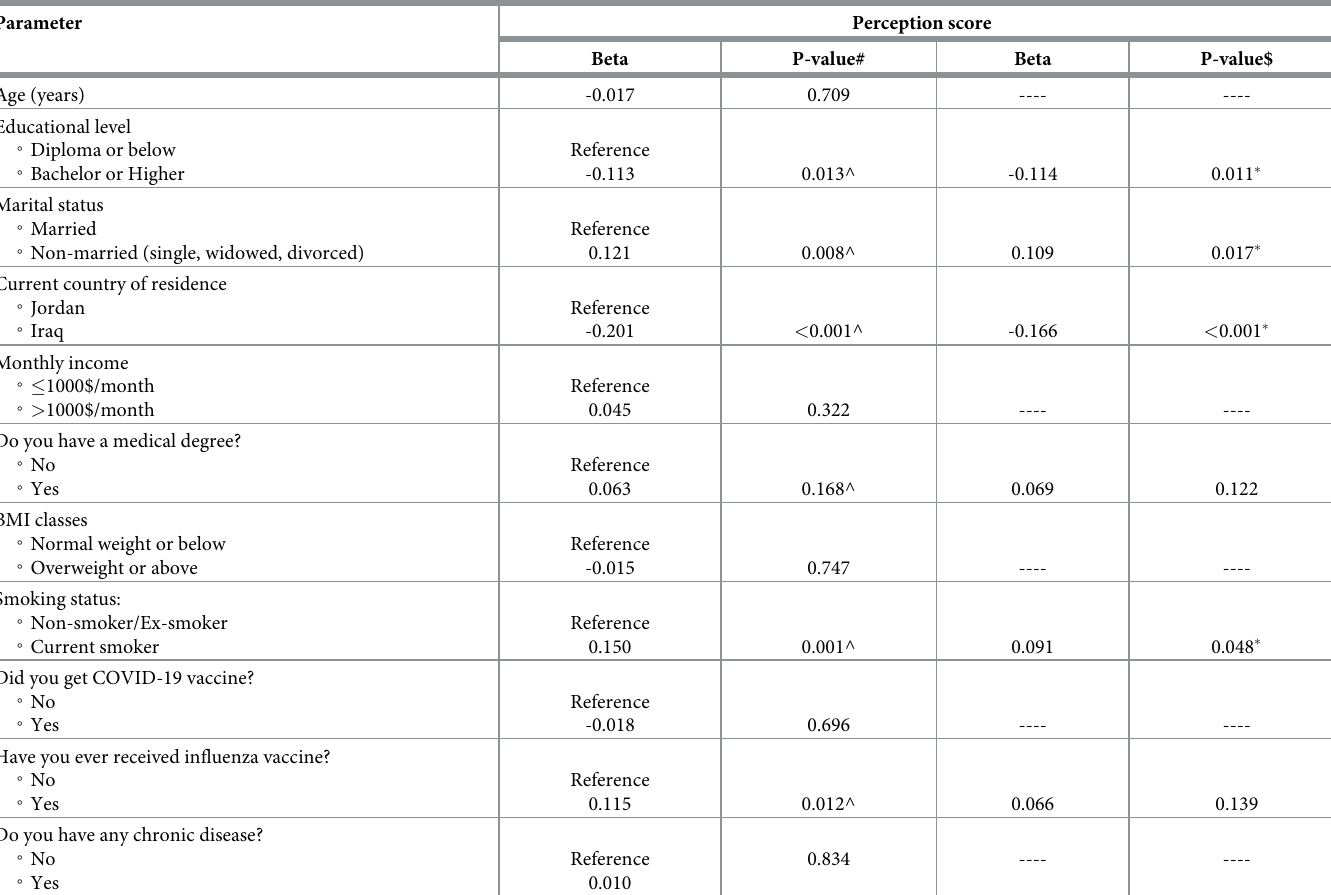
Table 4. Assessment of factors affecting participants’ perception towards the impact of COVID-19 infection on the menstrual